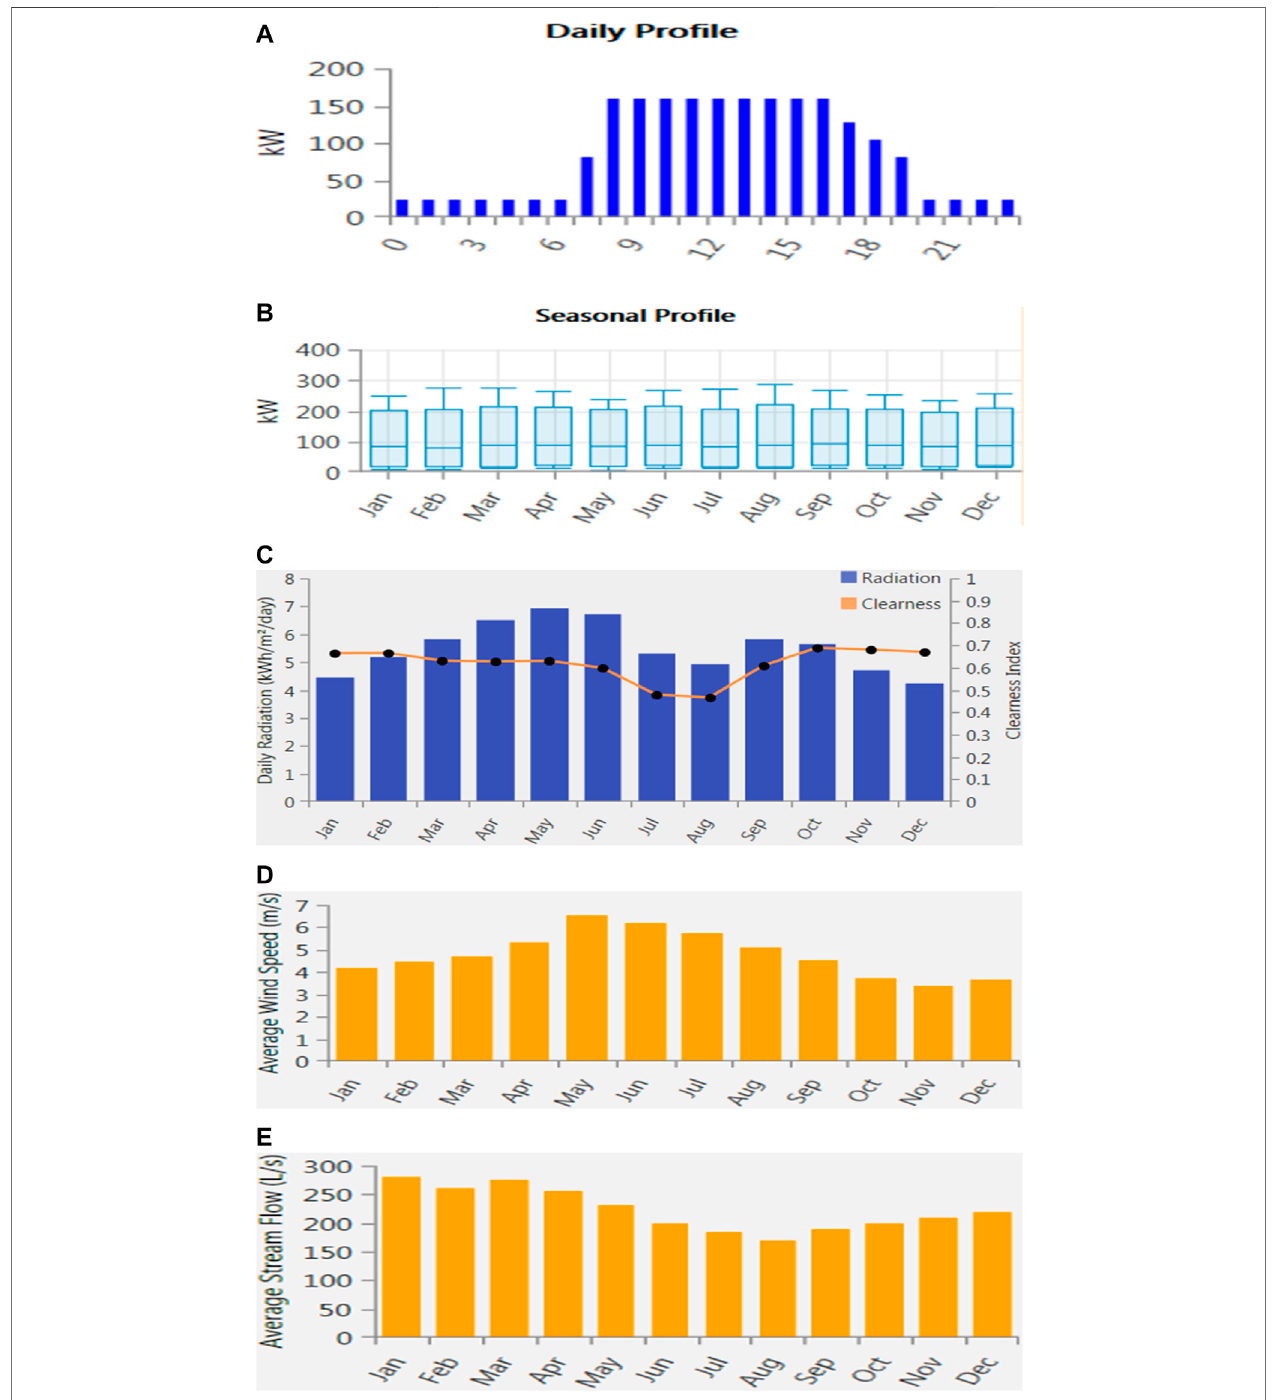
FIGURE 2 | (A) Daily load pro fi le. (B) Seasonal load pro fi le. (C) Monthly average solar pro fi le. (D) Monthly average wind pro fi le. (E) Monthly average hydro pro fi le.